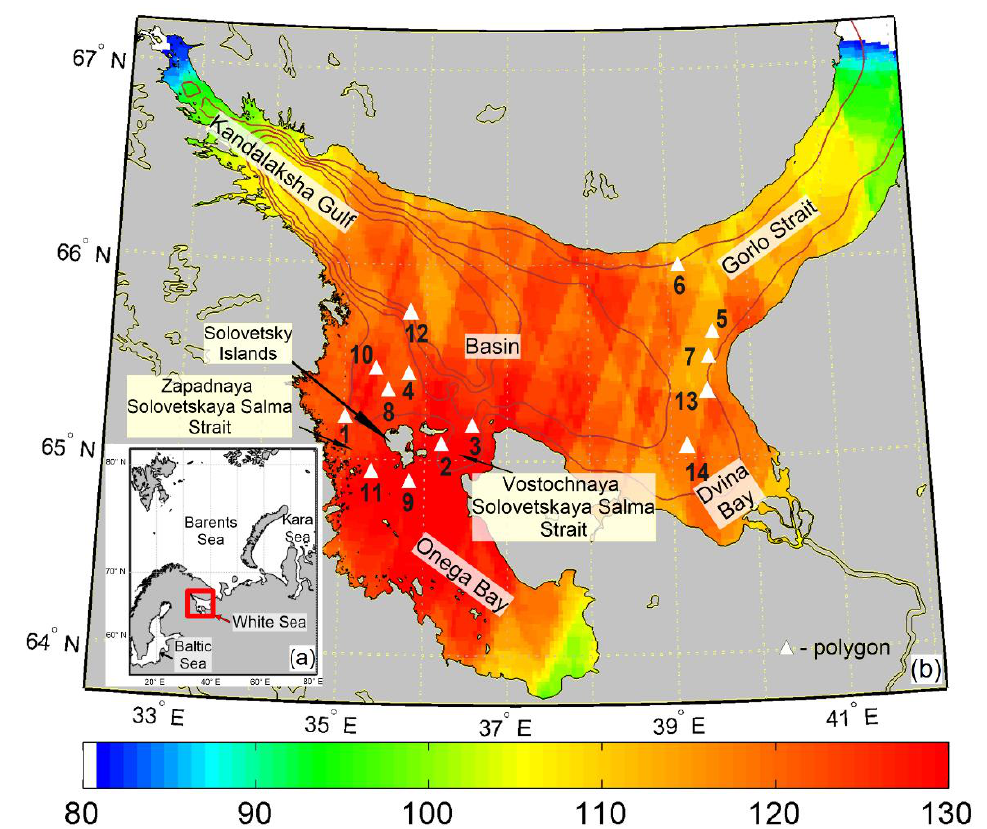
Figure 1. ( a ) Map of the Northern Europe with the location of the White Sea marked by red box. ( b ) Spatial coverage of the study site using satellite SAR data. The number of available SAR images is shown in color. White triangles and numbers mark the locations of polygons of contact measurements made in 2009–2014. Overlaid grey lines are isobaths drawn with a 50 m step taken from IBCAO v.3.0 [16].